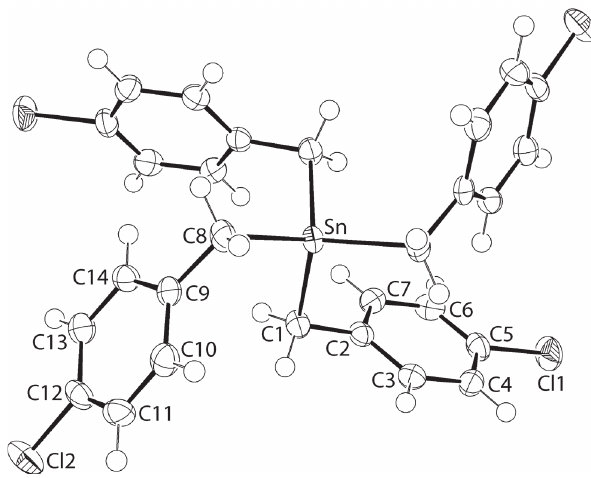
Table 1: Data collection and